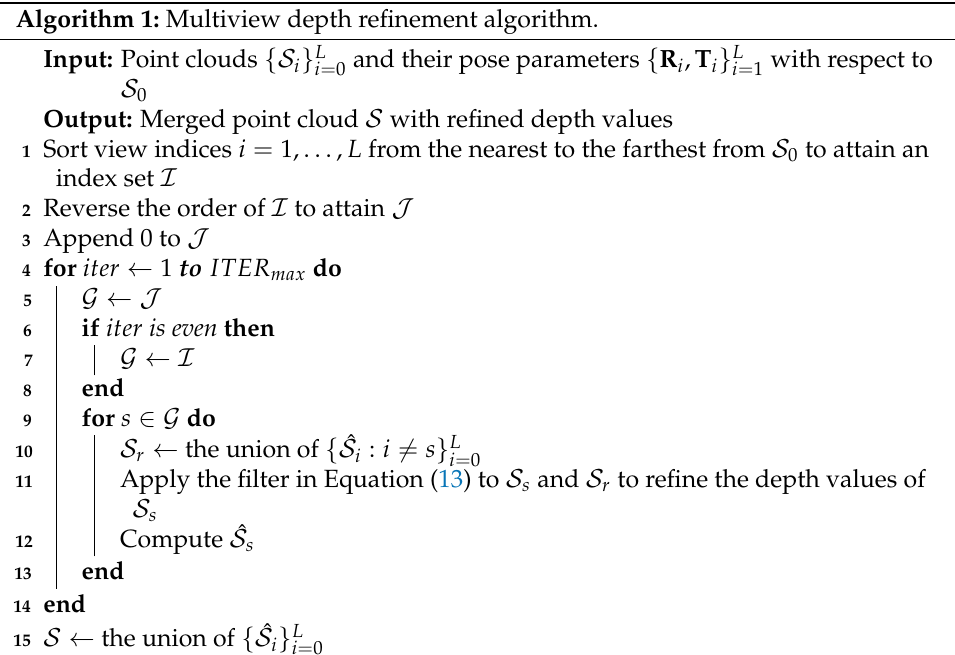
Algorithm 1: Multiview depth refinement